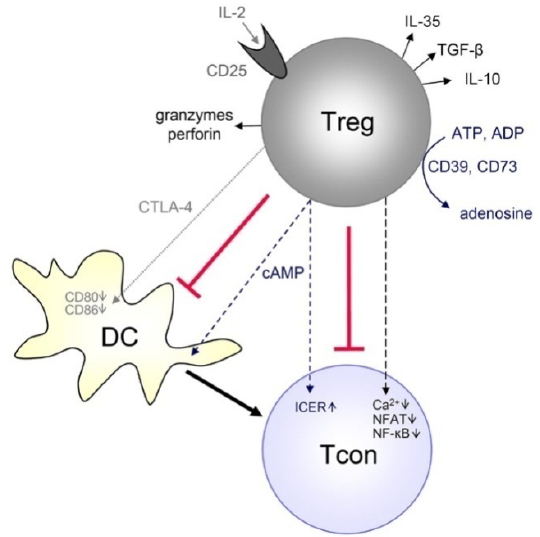
Figure 2. Activation of CTLA-4 in Treg cells leads to the inactivation of the immune response. α CTLA-4 can be used to mask the activity of Treg cells, thus enhancing the T cell binding